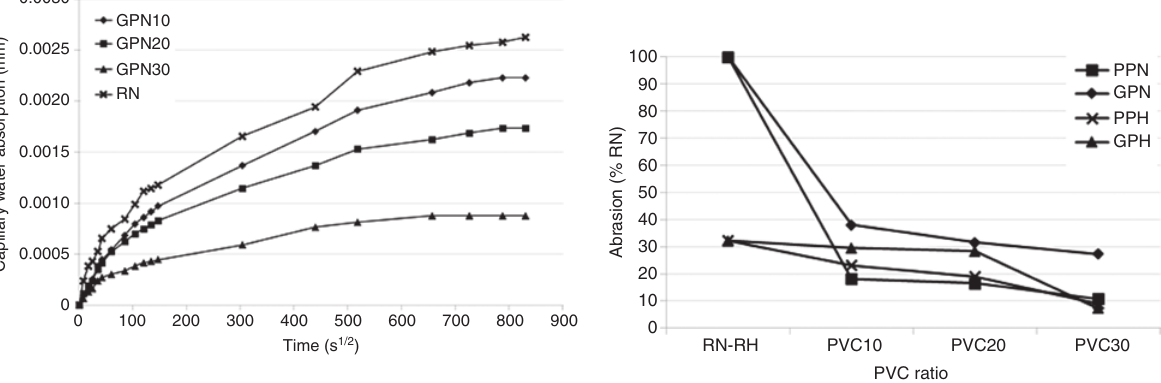
Figure 17 Abrasion differences compared to reference